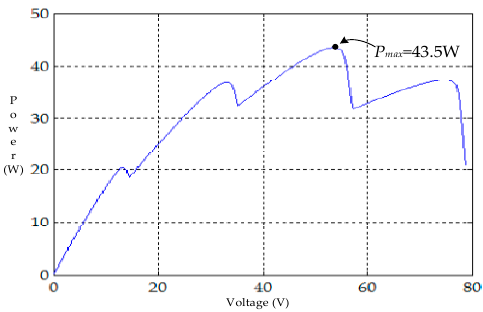
Figure 13. Simulation of P–V characteristic curve in Case 4.